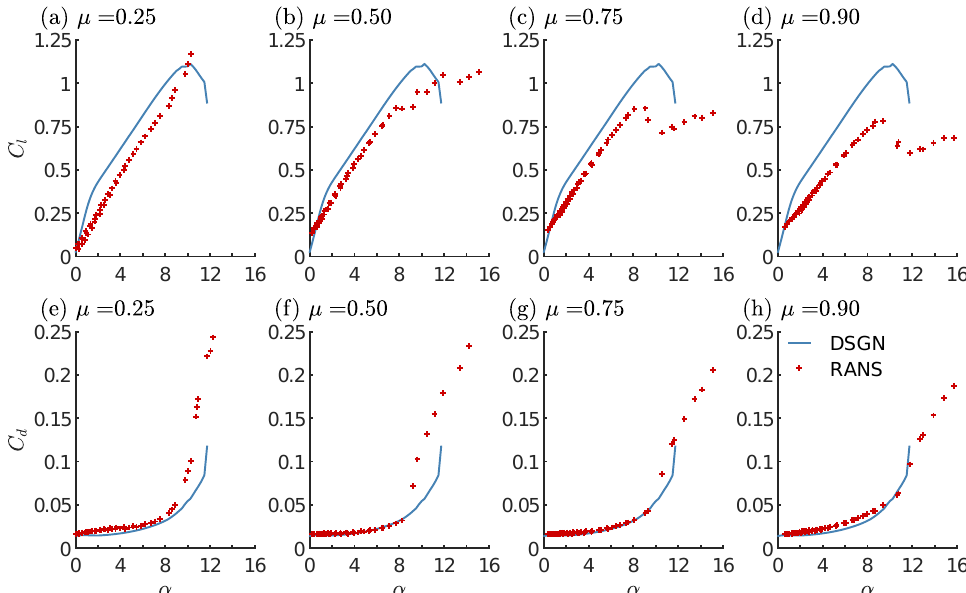
Figure 5. Comparison of blade polars obtained from 2D airfoil calculations (DSGN), and numerical simulation (RANS): ( a – d ) lift C l and ( e – h ) drag C d coefficients as function of AoA θ at selected blade sections µ = r / R =